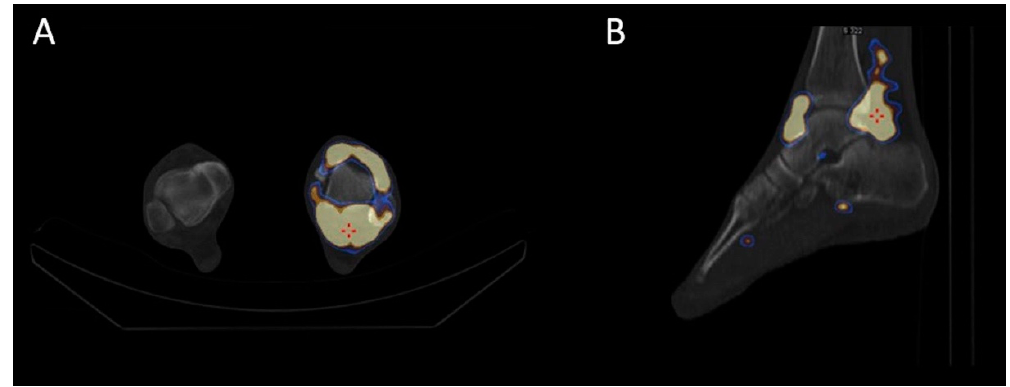
Figure 4. Imaging of the ankle joint performed immediately after intraarticular application of 169 Er.